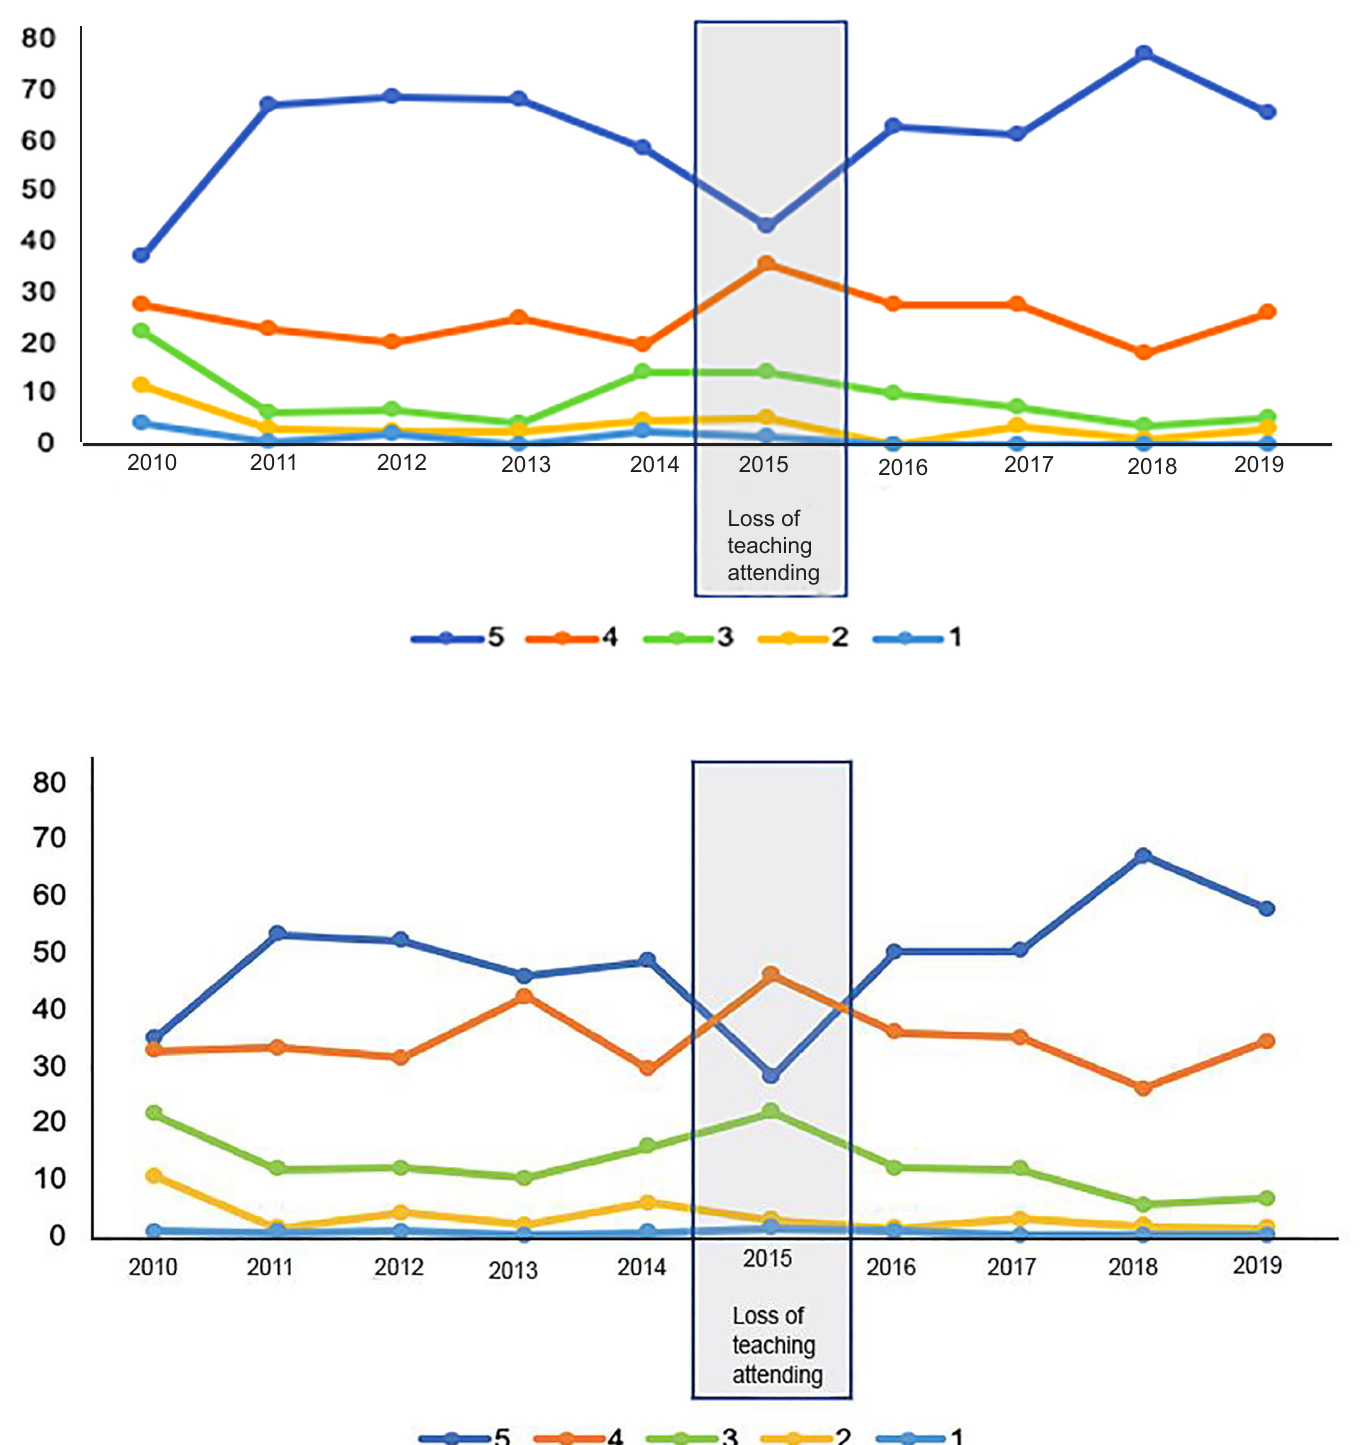
Figure 1. Percentage of ratings for evaluation items related to quality of the clinical teaching and overall clerkship quality across graduating